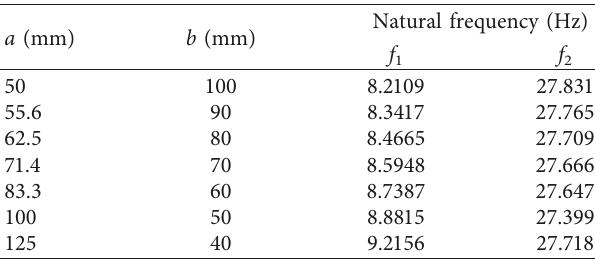
Figure 4: Variations of the natural frequencies of the plate supposed differently with various cutout areas. Table 2: Influence of ellipse shape on the first two frequencies of clamped-free